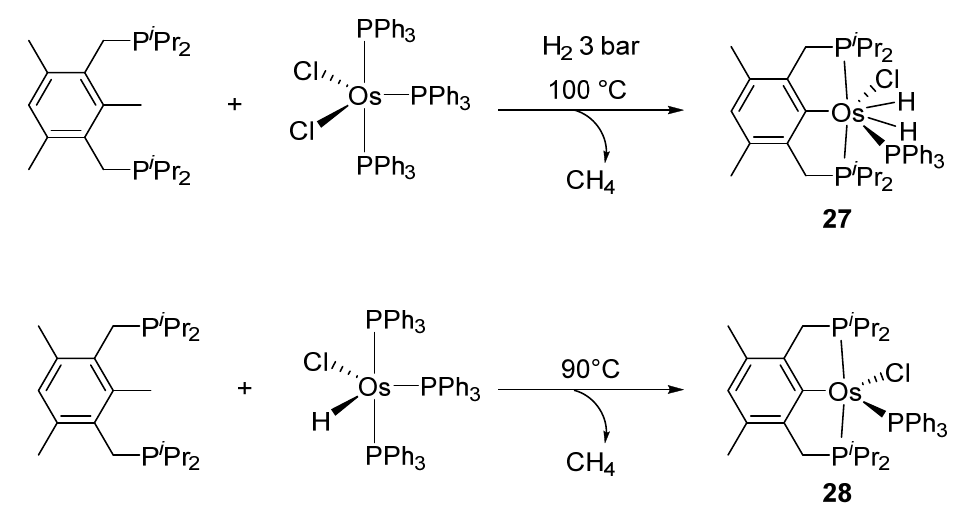
Figure 6. Synthesis of P~C~P pincer complex from 1,3-(R 2 PCH 2 ) 2 C 6 H 4 . The diphosphine {1,3,5-(CH 3 ) 3 -2,6-( i Pr 2 -PCH 2 ) 2 C 6 H} was also reacted with [OsCl 2 (PPh 3 ) 3 ]. The metal promotes the cleavage of one C − CH 3 bond with liberation of methane (Figure 7). In the presence of H 2 , dihydride heptacoordinated complex 27 is formed, while [OsH(Cl)(PPh 3 ) 3 ] generates a pentacoordinated complex 28 [41].